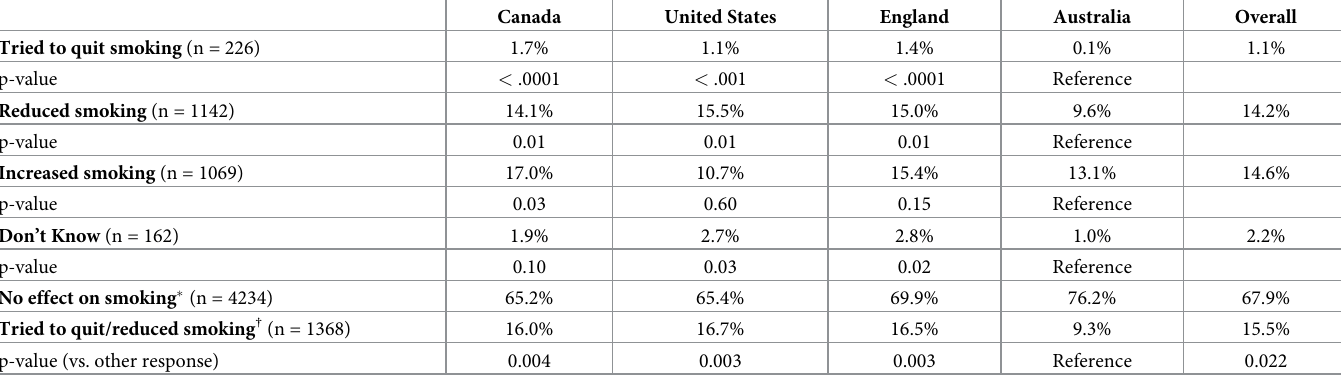
Table 3. Primary smoking behavioural reaction to COVID-19, overall and by country